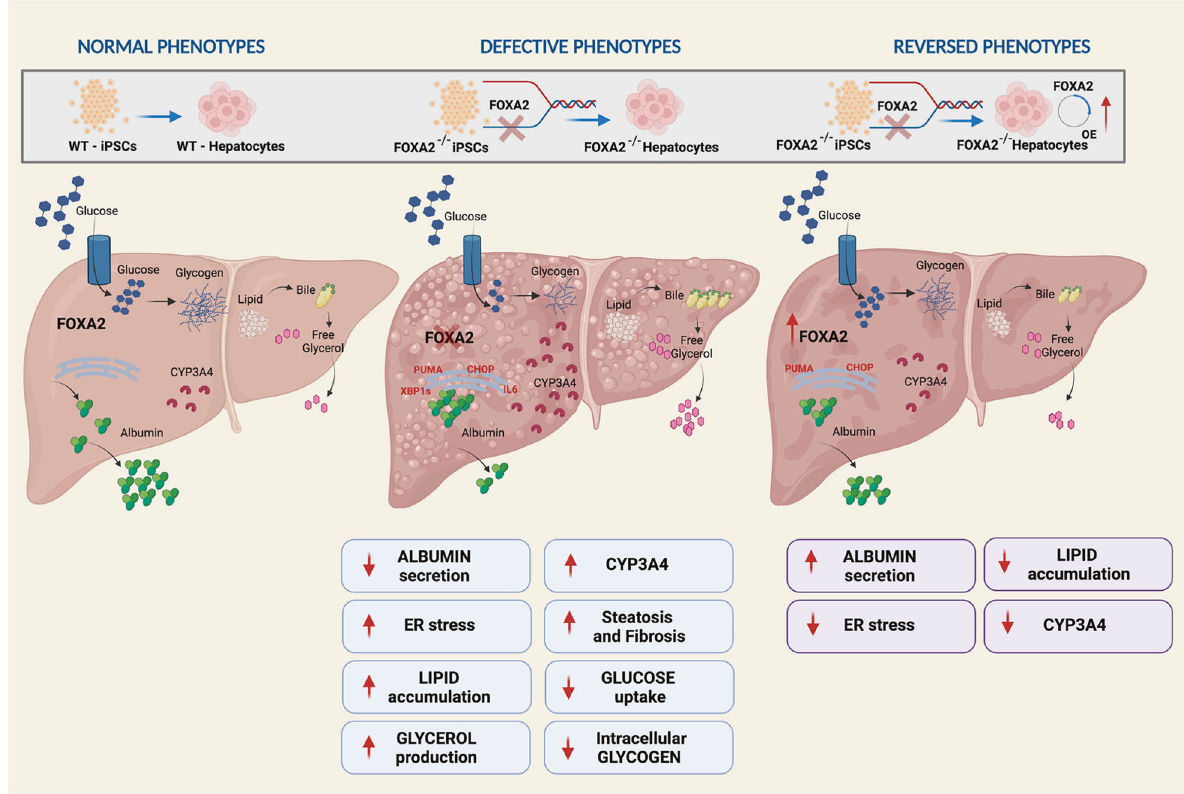
Fig. 8 Graphical representation summarizing the role FOXA2 in the development and function of human hepatocytes. Absence of FOXA2 during the development of iPSC-derived hepatocytes alters developmental gene expression, reduced ALBUMIN secretion, induced ER stress, increased hepatic steatosis, and decreased glucose uptake and glycogen accumulation. However, overexpressing FOXA2 at a hepatic progenitor stage, reversed these defective